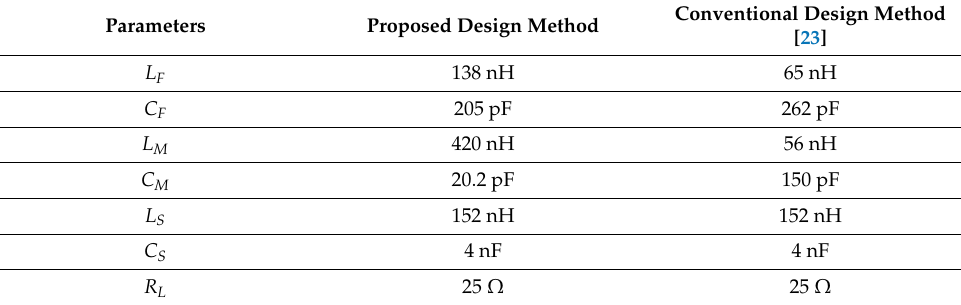
Table 2. Circuit parameters with different design methods.